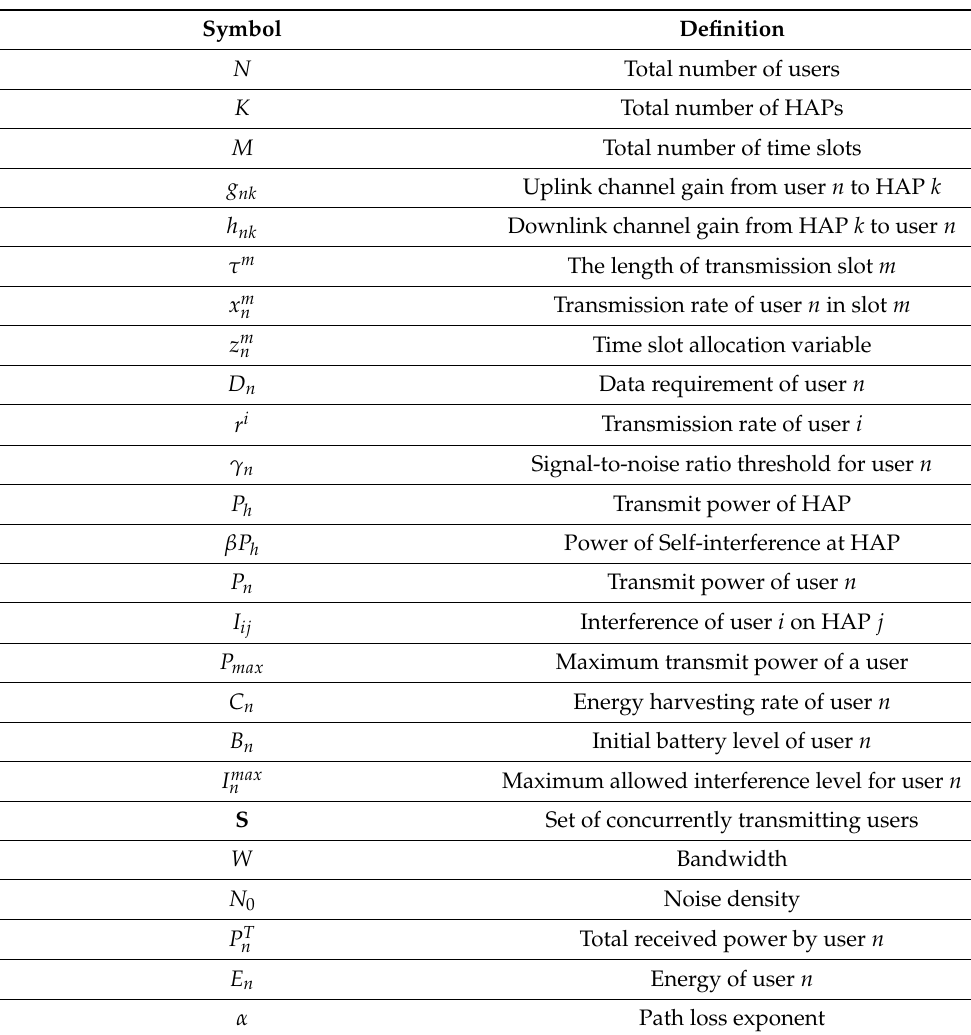
Table 1. Symbols and